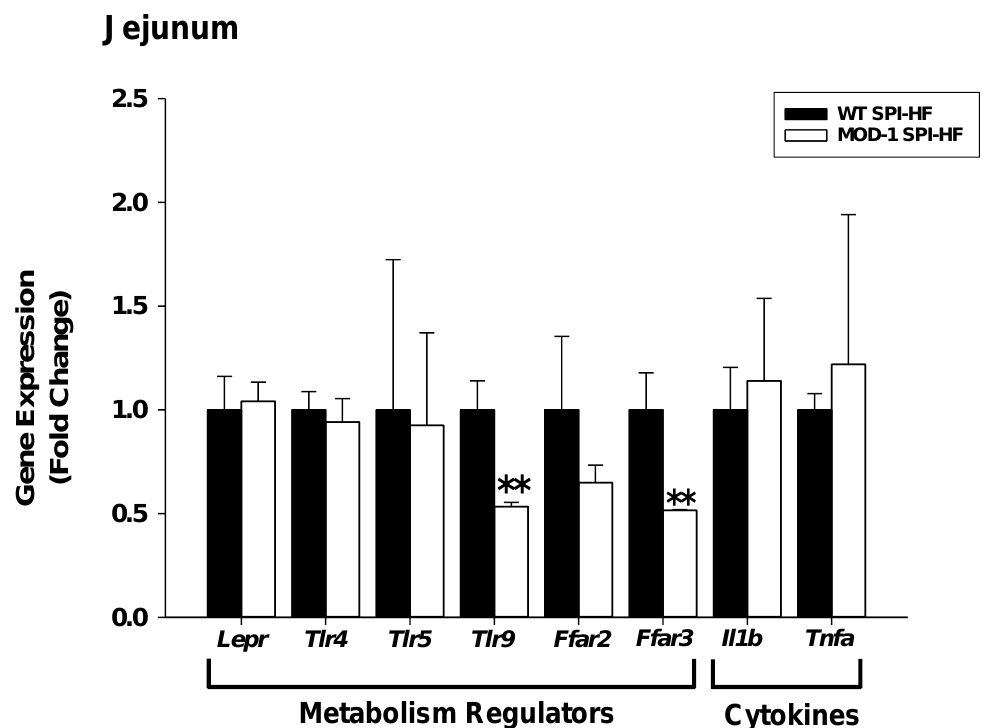
Figure 11. Differences in specific gene expression in jejunums from WT and MOD-1 female mice who were fed an obesogenic diet. Quantification (via qPCR) of transcripts encoding select immunomodulatory and metabolic regulatory proteins. qPCR used Actb and Tbp as normalizers, followed by application of geNorm [25]. Data are mean ± SD for n = 10 WT and n = 11 MOD-1 mice. ** p < 0.01.